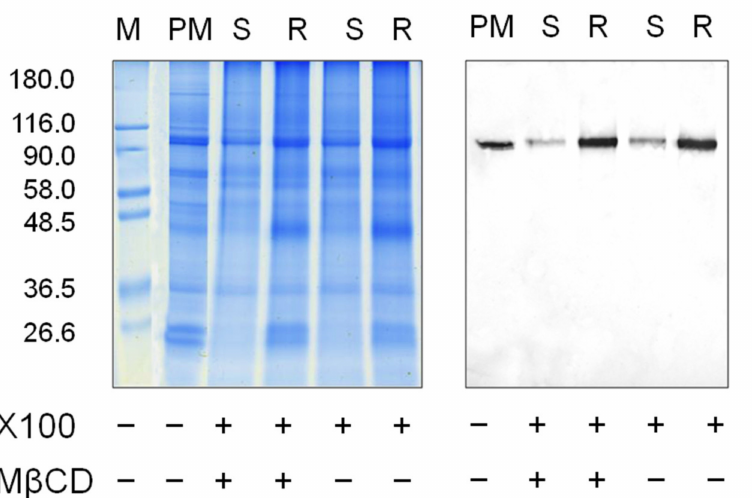
Figure 7. Effects of M β CD on protein distribution (left) and H + -ATPase content (right) between Triton X-100-resistant (R) and X-100-soluble (S) plasma membrane (PM) fractions obtained after separation in iodixanol density gradient. Plasma membranes were pretreated with 10 mM M β CD before adding Triton X-100. R and S correspond to bars 3 and 4 from Figure